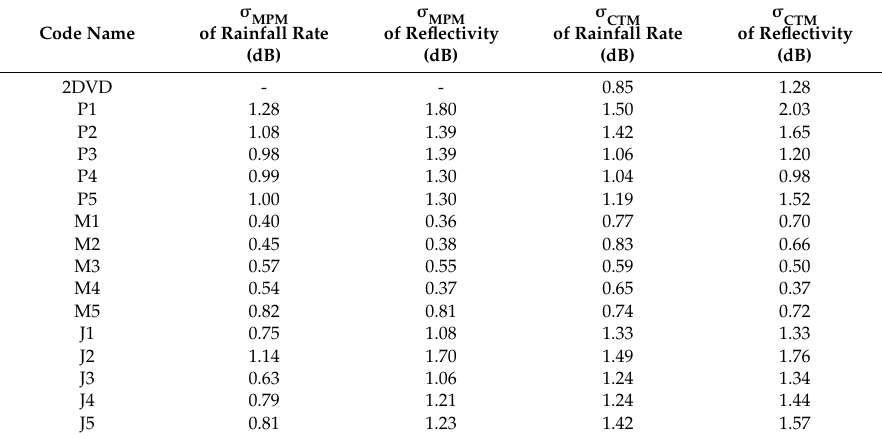
(Table 5). MRR had the σ of Z varied from 0.33 to 0.71 dB and the values of the ρ were from 0.99 to PM 1.0 (Table 6). The values of σ of Z also suggest that M5 is the noisiest (Table 5). JWD had the σ MPM Z from 1.07 to 1.54 dB and values of ρ of 0.96 to 0.98 (Table 6). J2 also showed a relatively higher σ of Z. These analyses indicate that the JWDs are noisier than MRR, but less noisy than POSS (Table 5). Table 5. Standard deviation ( σ ) of measurement noise of rainfall rate (R) and reflectivity (Z) estimated from multiple paired measurements (MPM) and paired “cross-type” measurements (CTM).